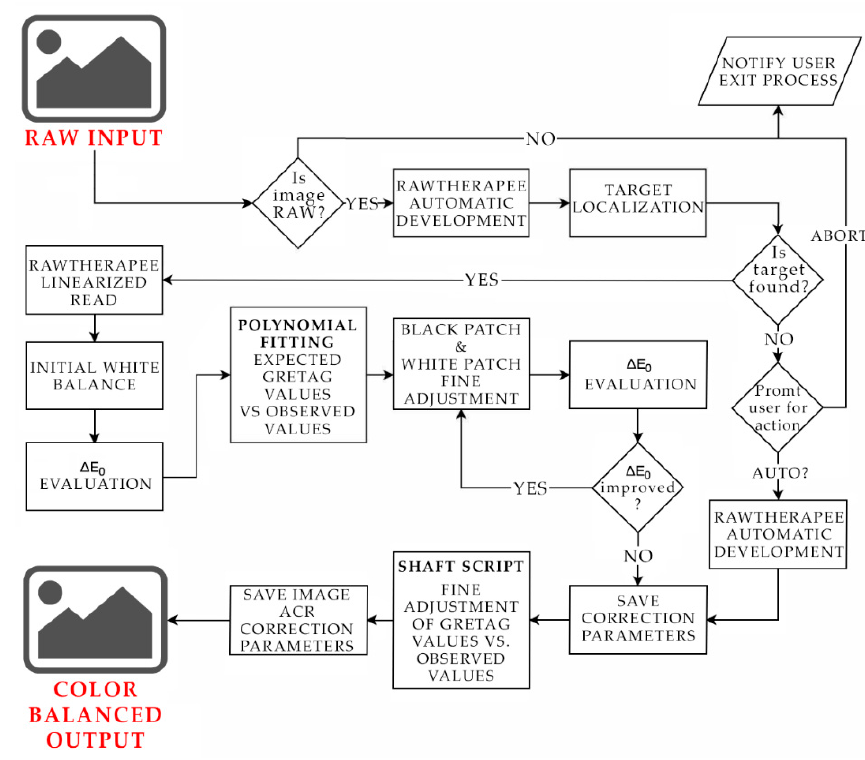
Figure 8. The color correction (CC) workflow.